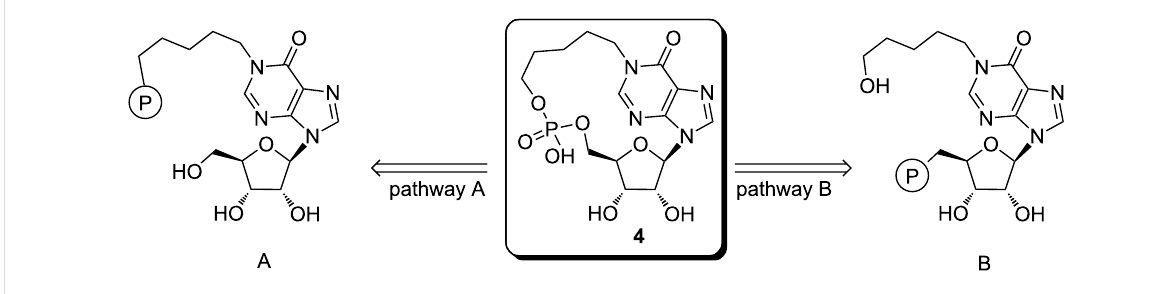
Figure 2: Synthetic strategies explored in the cyclization step via phosphodiester bond formation.